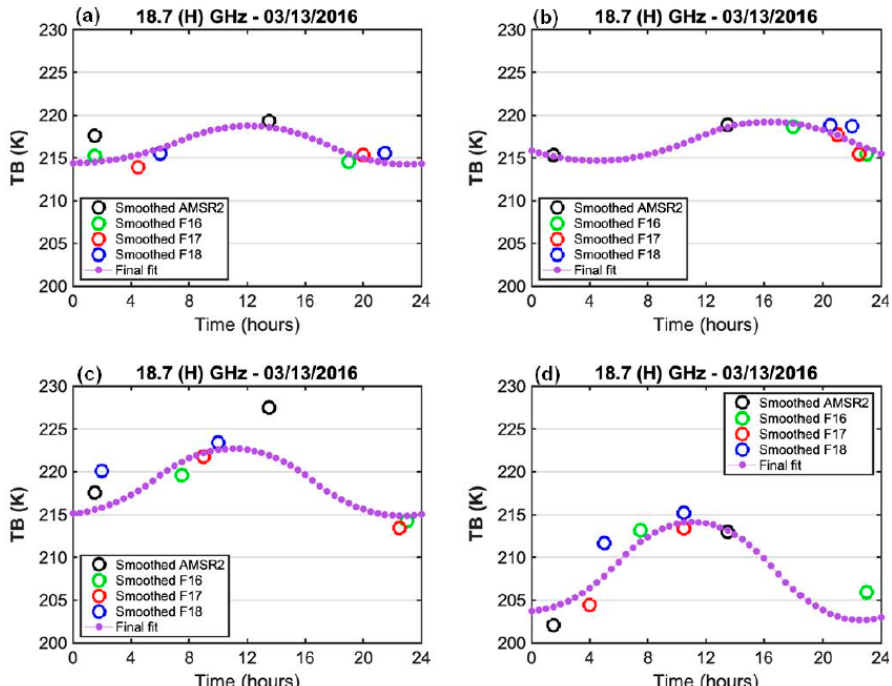
Figure 6. Diurnal variations of interpolated TB out of smoothed SSMIS F16, F17, F18, and AMSR2 for sample locations with different land covers for 13 March 2016 at 18.7 GHz horizontal polarization for ( a ) 71.5 ◦ S and 12.9 ◦ E with ice land cover, ( b ) 73.7 ◦ N and 122 ◦ W with tundra and mossy bog land cover, ( c ) 71 ◦ N and 114 ◦ E with deciduous woodland land cover, and ( d ) 77 ◦ N and 106.4 ◦ E with non-vegetated desert land cover. Time in each subplot is in local solar